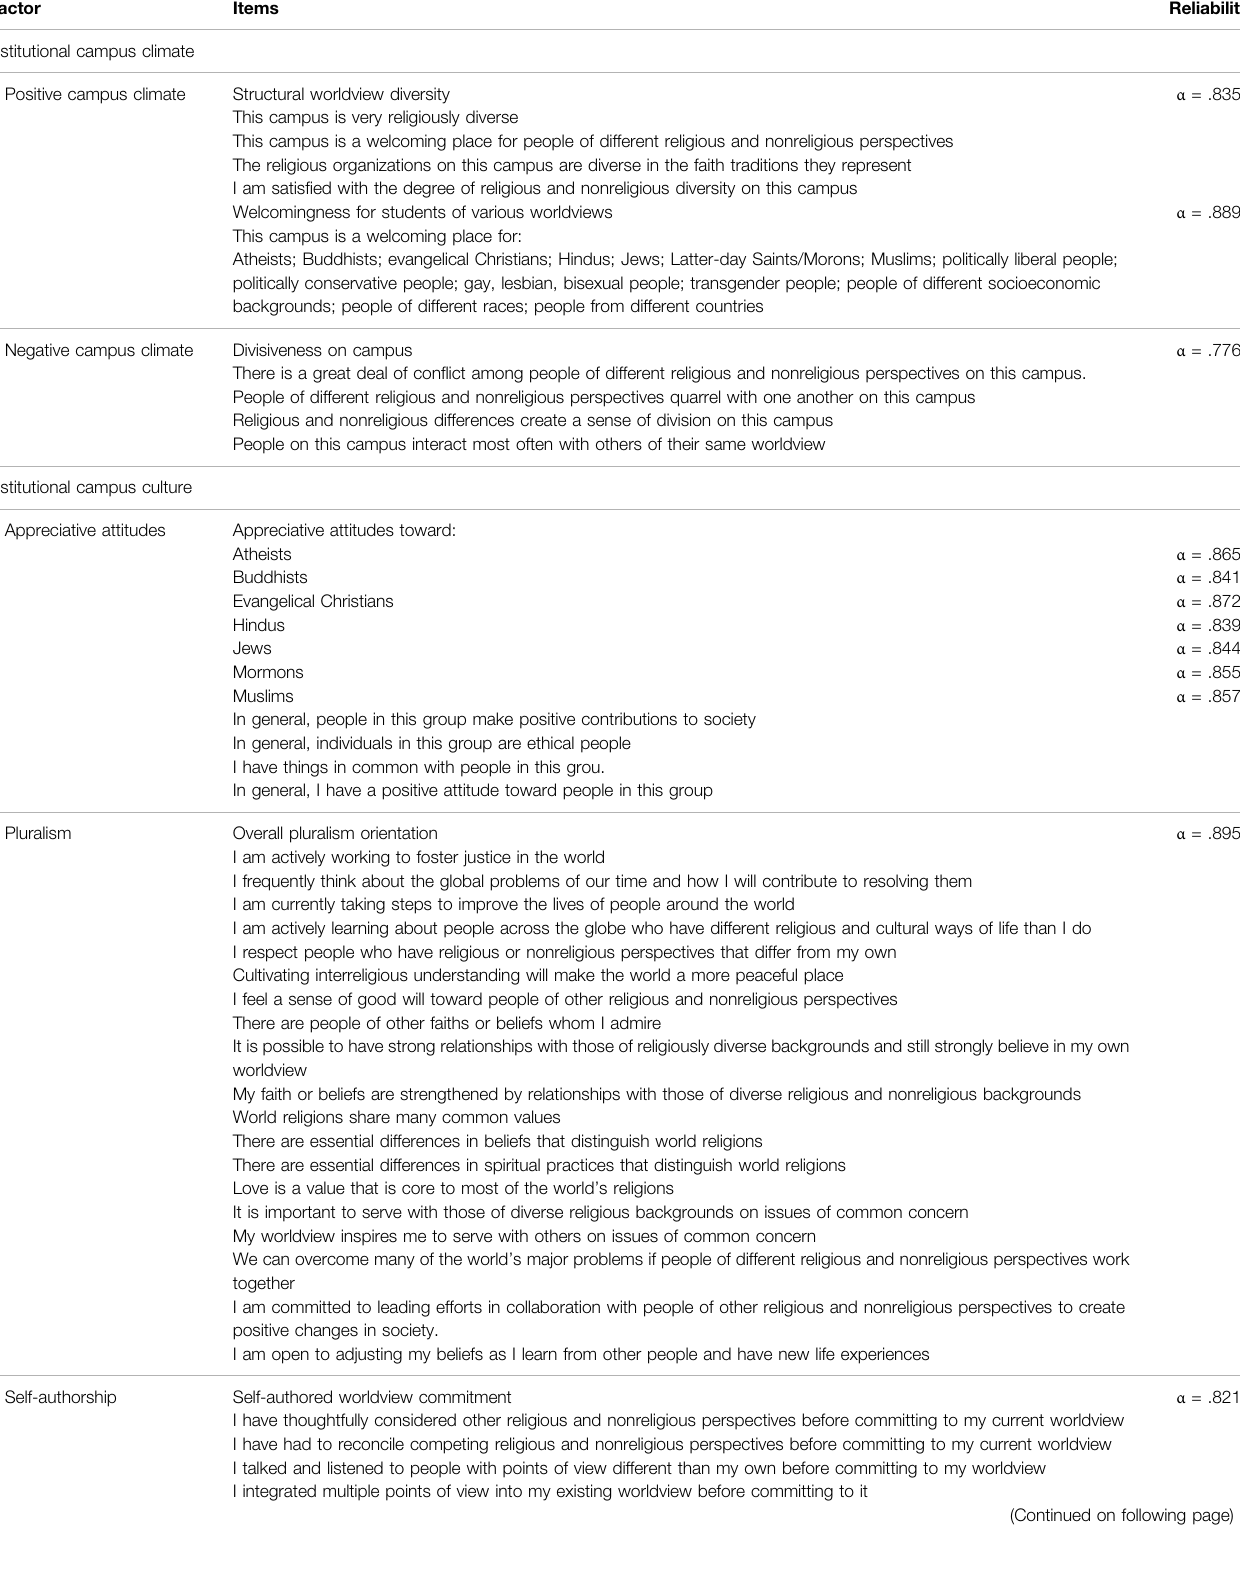
TABLE 2 | Interfaith learning and development model factors and items for institutional and relational